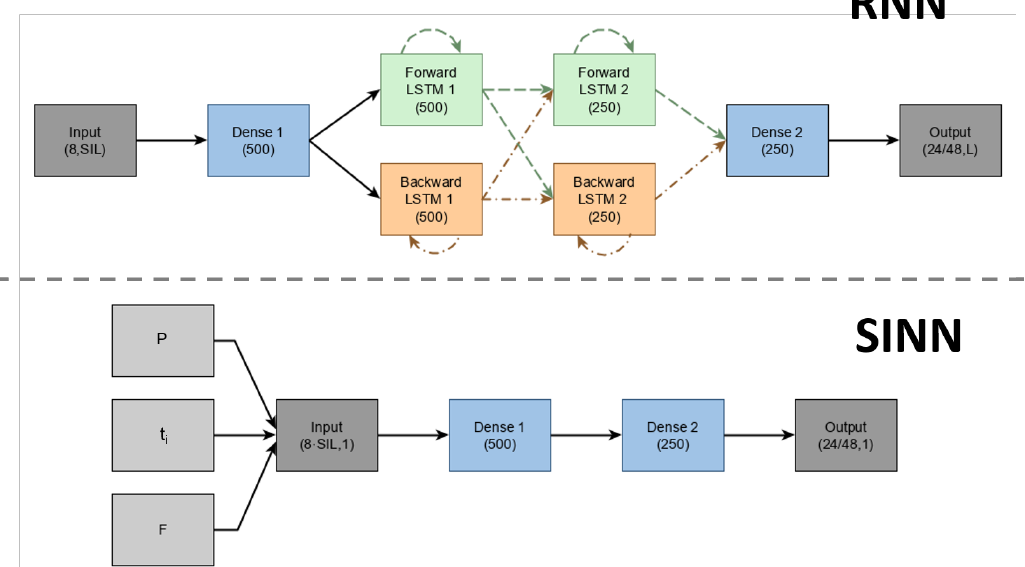
Figure 3. The implemented network architectures for the deep (RNN) and shallow (SINN) learning approaches. Different networks were trained for estimating upper/lower-body poses, which resulted in 8 inputs (2 segment orientations, represented by quaternions, relative to the pelvis) times SIL (stacked input length) poses for both SINN and RNN. Furthermore, a different number of outputs was obtained from the separate networks, namely, 24 for the lower body and 48 for the upper body . Input to the SINN is stacked with adjacent poses from past (P), current ( t i ) and future (F) time samples, resulting in a total of L samples that are taken into account. The same sequence can be provided as an input matrix to the RNN, which produces a sequence as output (and the relevant pose can be used). The different types of hidden layers are shown by the various colours with the corresponding number of neurons shown in